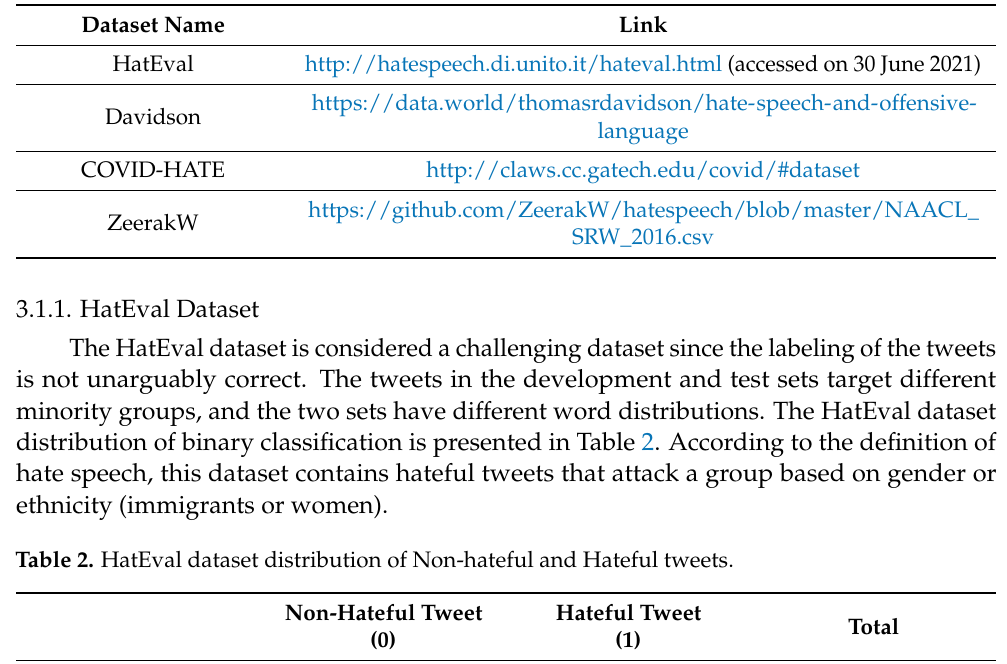
Table 1. Datasets used in this study.